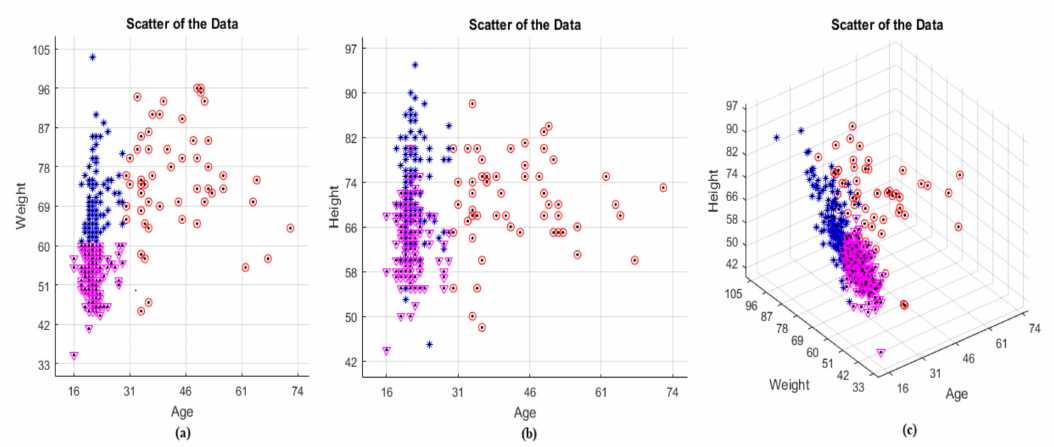
Figure 3. Clusters of data; ( a ) Age-Height view; ( b ) Age-Weight view; ( c ) View of all data.